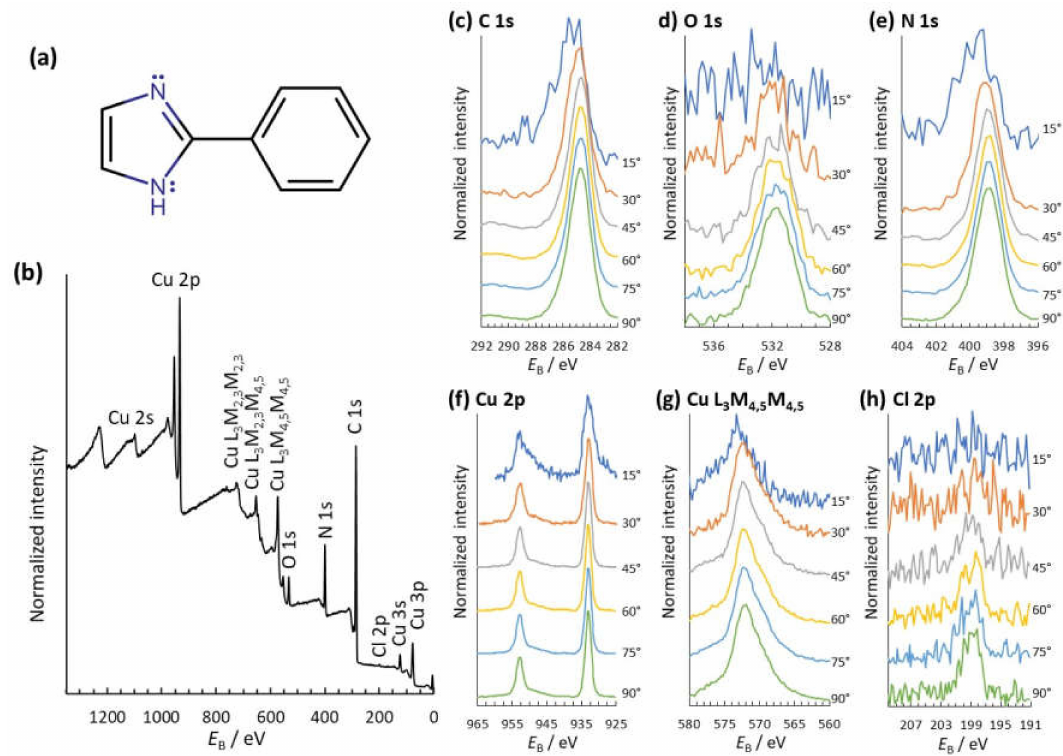
Figure 1. ( a ) The chemical structure of the 2PhI molecule. XPS analyses of the 2PhI-treated Cu: ( b ) survey and HR ARXPS spectra for ( c ) C 1s, ( d ) O 1s, ( e ) N 1s, ( f ) Cu 2p, ( g ) XPS-excited Cu L 3 M 4,5 M 4,5 , and ( h ) Cl